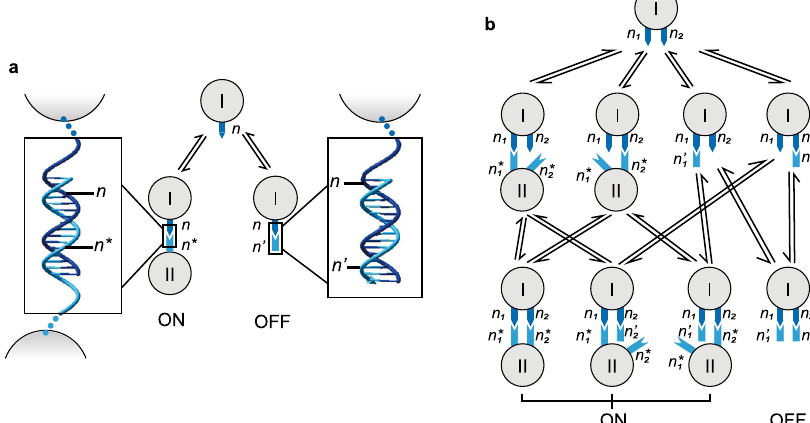
Fig. 1 Schematic diagrams of controllable dynamics of DNA nanostructures based on toehold-free strand displacement. Tree maps of binding reactions of ( a ) one species of blocker to displace one species of pre-speci fi ed segment ( nn *) or ( b ) two species of blockers to displace two species of pre-speci fi ed segments ( n 1 n 1 *, n 2 n 2